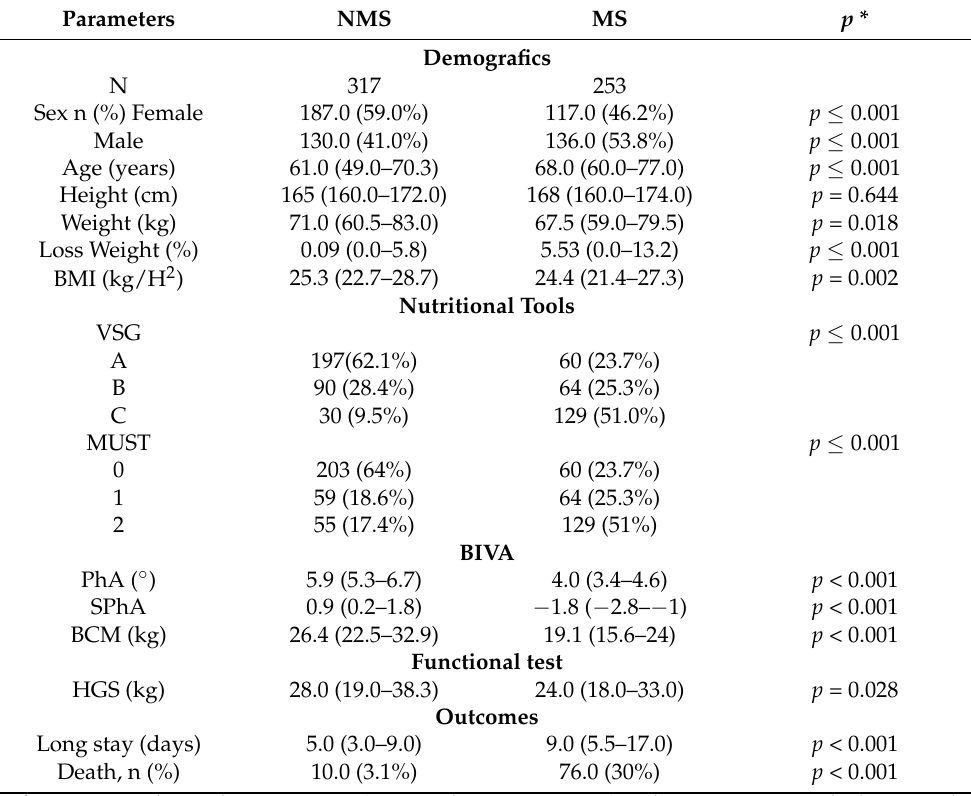
Table 3. Demographic parameters, nutritional tools, BIVA, Functional test and Outcomes results by SPhA-Malnutrition. Parameters NMS MS p * Demografics